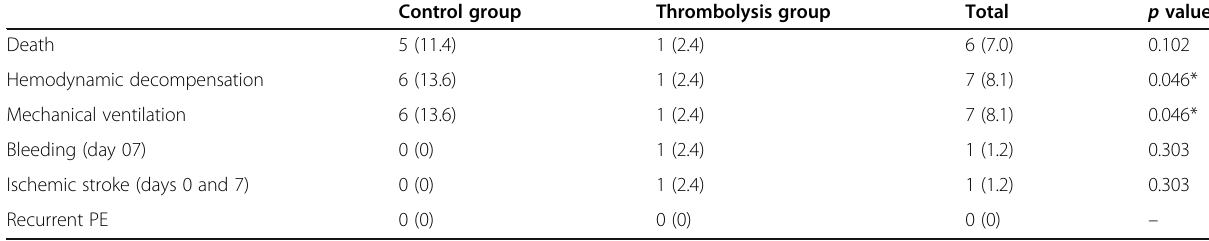
Table 6 Outcome of the study population